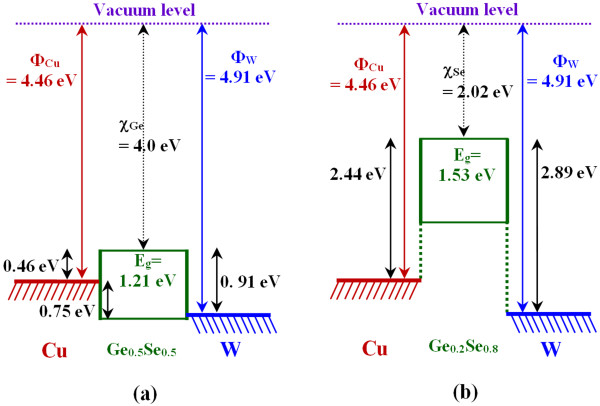
Schematic energy band diagrams of (a) Al/Cu/Ge0.5Se0.5/W and (b) Al/Cu/Ge0.2Se0.8/W structures.